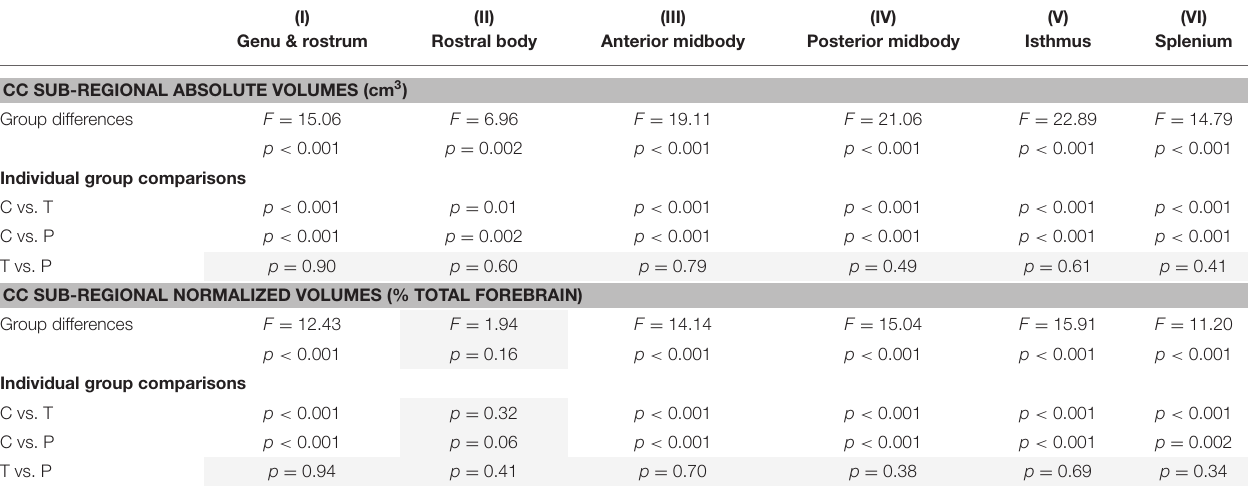
TABLE 2 | Analysis of sub-regional corpus callosum volumes.